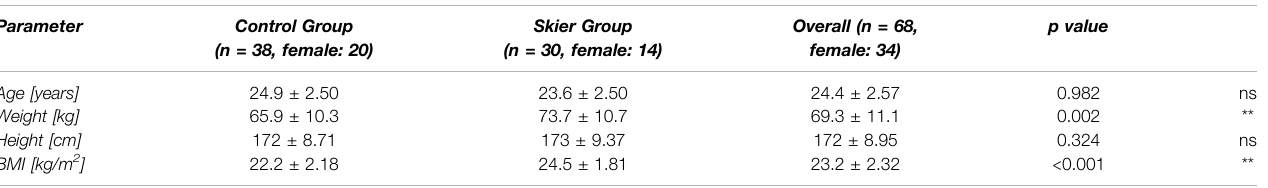
TABLE 1 | Baseline characteristics. Parameter Control Group (n = 38, female: 20)